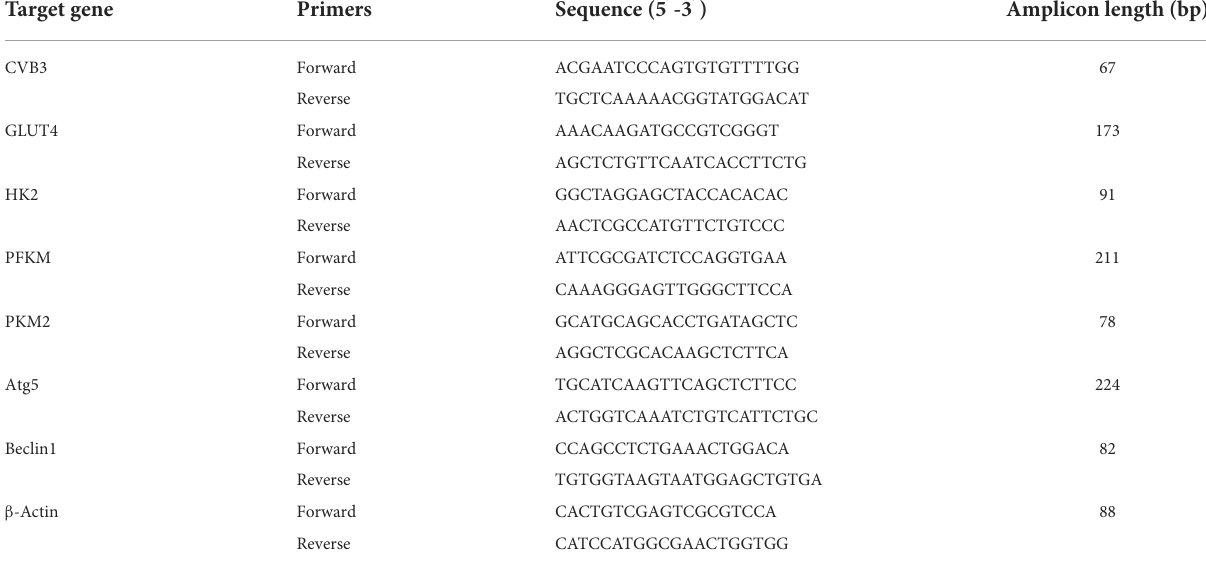
TABLE 2 Primers sequences for HL-1 mouse